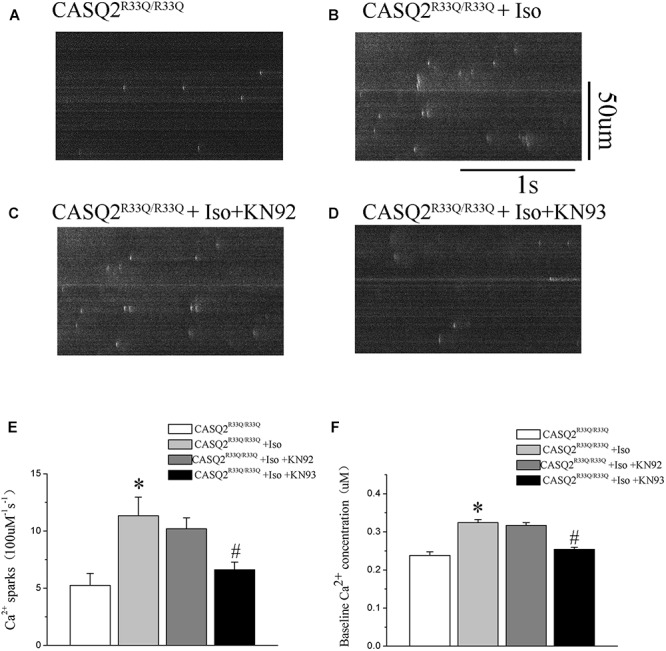
(A) The occurrence of EAD and DAD in the Casq2R33Q/R33Q group by recording AP. (B) DADs (red arrow) from the mutated atrial myocytes. (C) EADs (blue arrows) from mutated atrial myocytes. (D) Effects of CaMKII inhibition with KN93 (1 μM) on membrane oscillations in Casq2R33Q/R33Q myocytes. DADs/EADs were defined as membrane depolarization more than 20 mV. (E) Proportion of cells with EADs or DADs at 1 Hz in the Casq2R33Q/R33Q and the WT groups with or without Iso. (F) Resting membrane potential (RMP) with Iso or without Iso between the two groups, and with Iso plus KN93 in the R33Q group. Each point/bar represents the mean ± SEM. ∗P < 0.05 vs. WT. #P < 0.05 when comparing the Iso group with the Iso plus KN93 group.